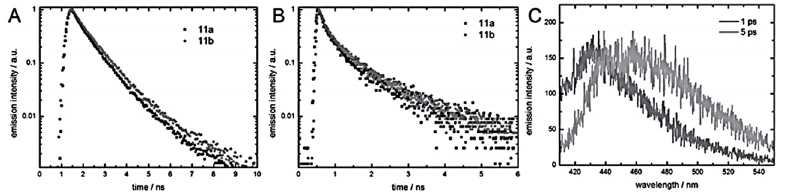
Figure 46. Time-resolved emission data of π -conjugated urethane-based polymer 11b (gray) recorded after 380 nm excitation in ( A ) chloroform and of ( B ) thin films. All decay curves have been spectrally integrated between 420 and 500 nm and normalized to their respective intensity maximum. ( C ) Integrated time-resolved emission spectra of 11a within 1 ns after excitation (gray) and between 1 and 5 ns after excitation (light gray). From reference [34].